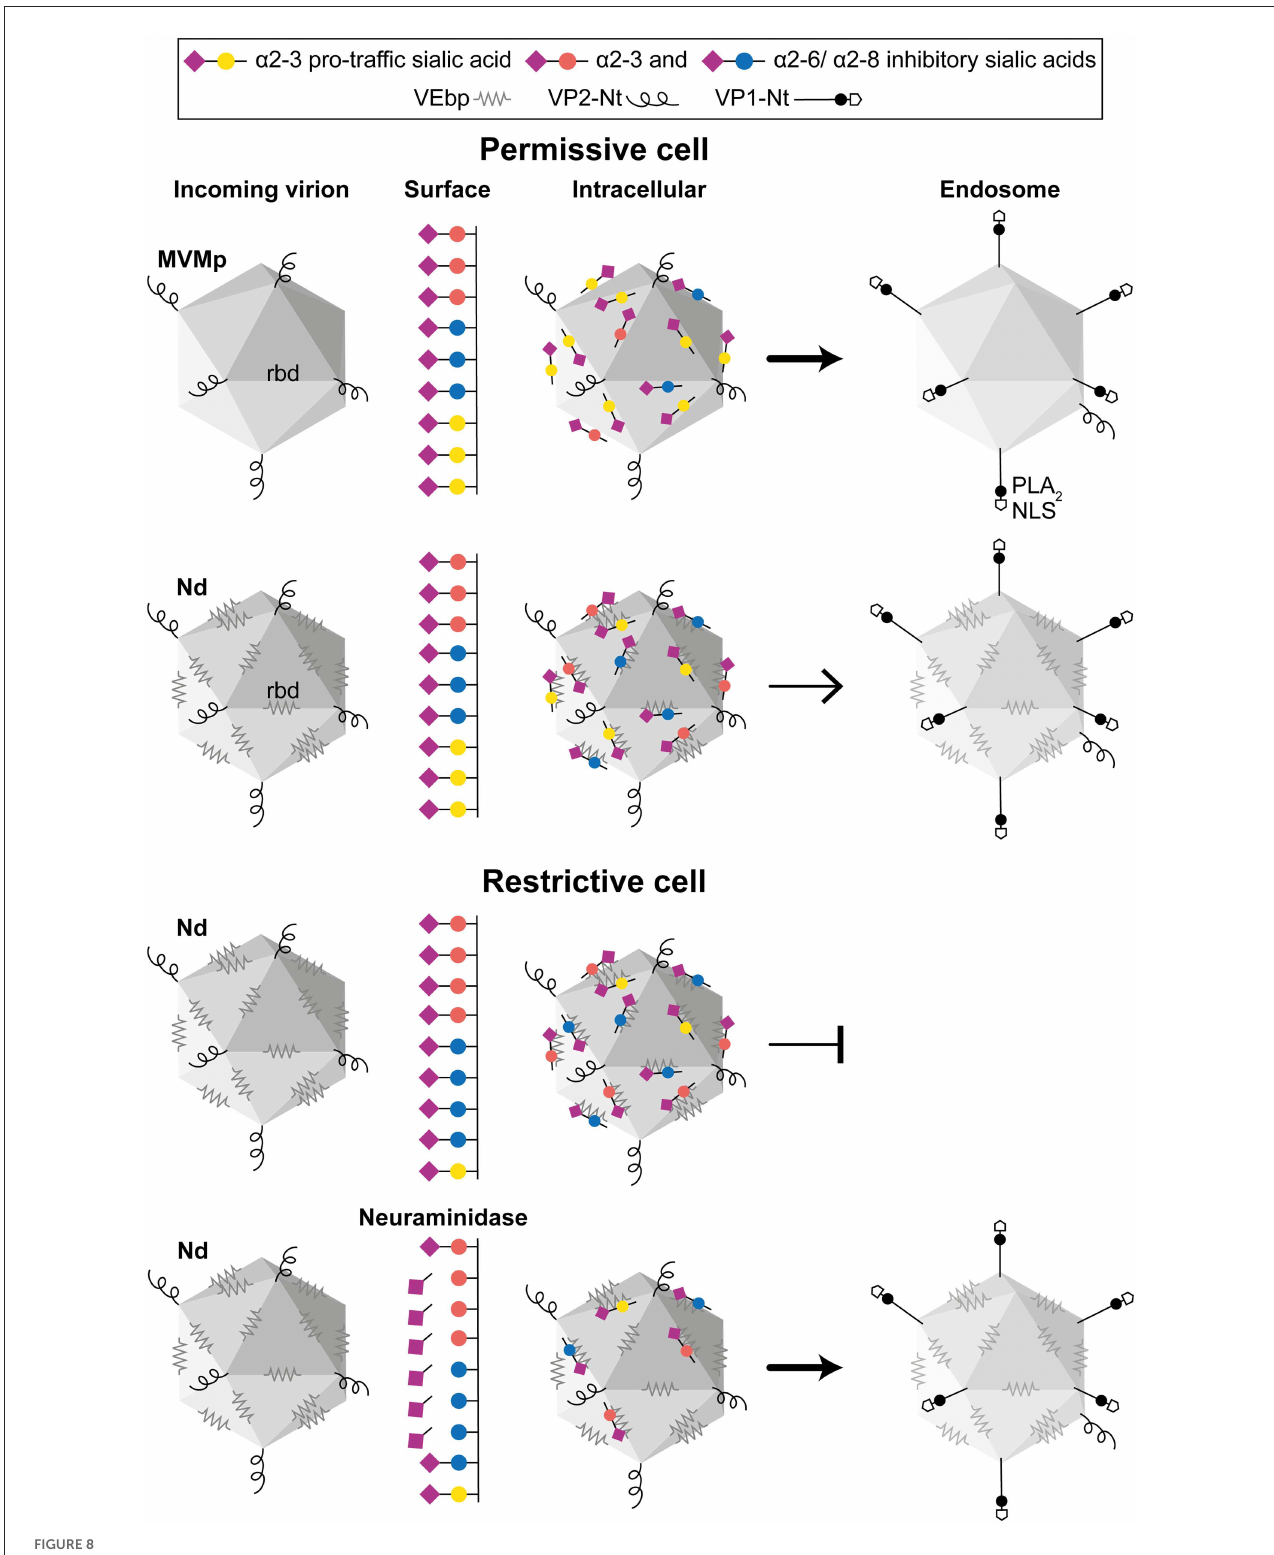
FIGURE8 The role of capsid–sia interaction on parvovirus tropism. The figure illustrates a general model on parvovirus entry on the basis of the MVMp and chimeric MVM-Nd infection of human permissive (fibroblasts) and restrictive (GBM)-transformed cells, harboring different surface composition of pro-traffic α 2-3 and inhibitory α 2-3 and α 2-6/ α 2-8-linked sia. (Upper) Both virions similarly bind to sia on the permissive cell surface, but the repertoire of sia moieties recognized by the specific residues of the rbd impacts the traffic to the endosome of the internalized virion. (Lower) Nonpermissive cells with higher proportion of inhibitory sia inhibit infection by precluding viral traffic to the endosome, which can be relieved by NA removal of inhibitory sia(s). For simplicity, only the Nd interaction has been illustrated here. In the productive infectious entry, viral capsids reach the low endosomal pH undergoing a drastic structural rearrangement that involves a de novo exposure and cleavage of the VP2-Nter of some protein subunits, which triggers the exposure of the VP1-Nter sequence. The VP1-Nter sequence harbors endosomal breaching membrane and nuclear localization sequences. rbd, Receptor binding domain in a dimple at the 2x axis; PLA 2 , phospholipase; NLS, nuclear localization